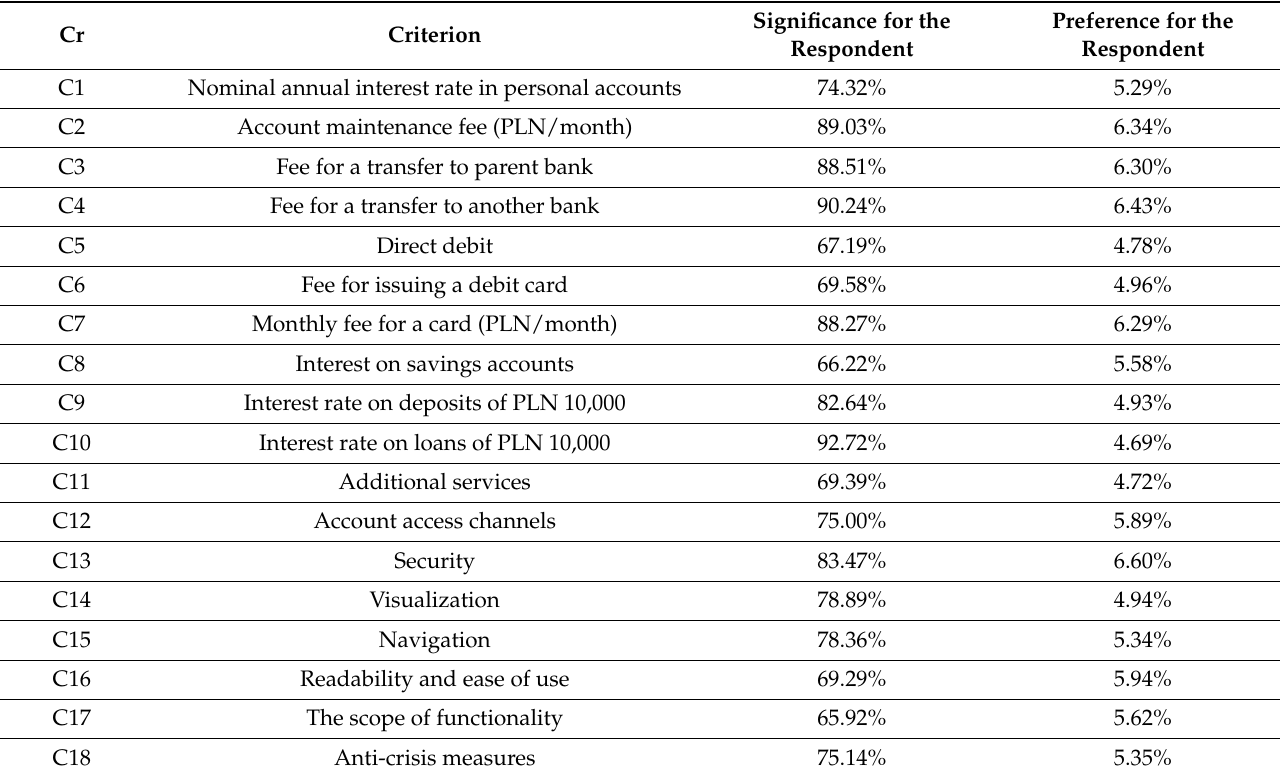
Table 6. The average value of significance and preference indicators for individual